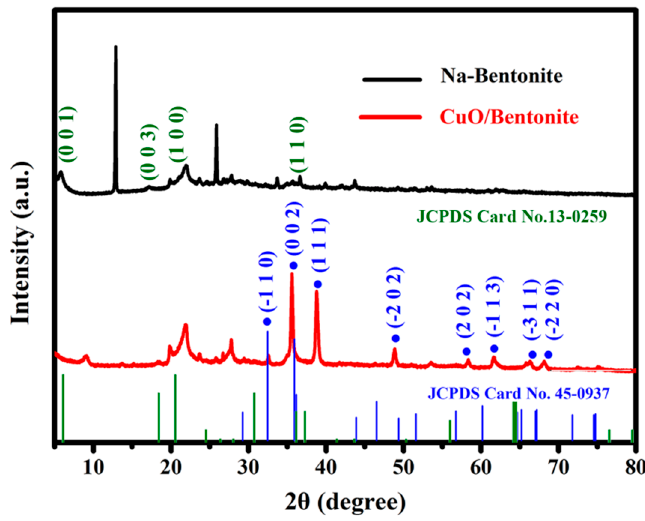
Figure 1. XRD of Na-bentonite and 1.4% CuO/bentonite(400°C) composite.